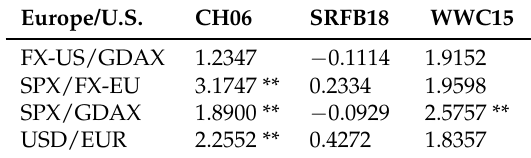
Table 6. Test statistics for stationary fractional cointegration between Europe and U.S.